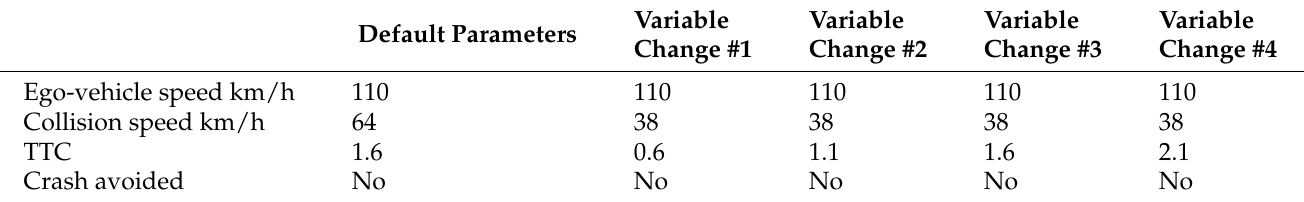
Table 5. Comparison of the effect of TTC that starts full braking.